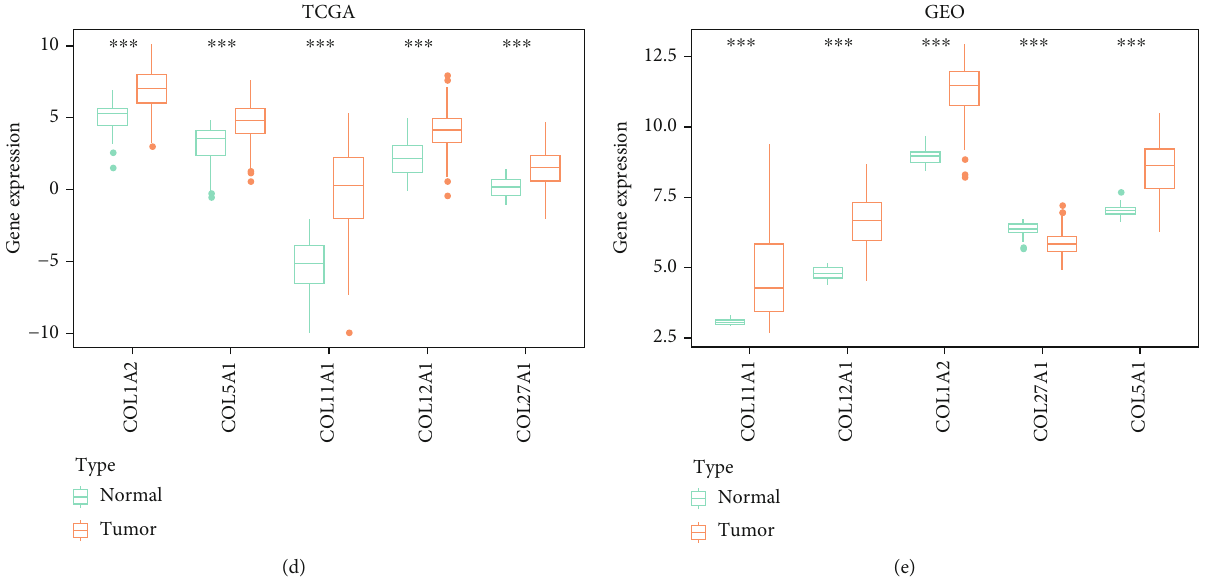
Figure 11: Target genes of the GIMiSig. (a) GO and (b) KEGG analyses of target genes. (c) PPI network of hub genes. The top 10 hub genes are indicated in red, orange, and yellow. (d) Expression of the 5 genes was compared between normal and tumor groups from TCGA and (e) GSE54129. Orange indicates the tumor group, and green indicates the normal group. ∗ p < 0 : 05 , ∗∗ p < 0 : 01 , and ∗∗∗ p < 0 : 001